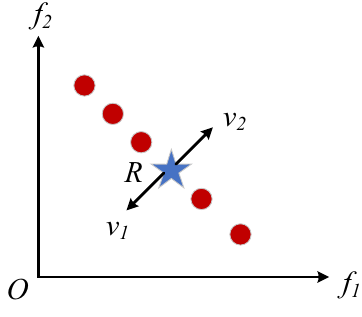
Fig. 4 The reference point and the non-dominated solutions are non- dominated